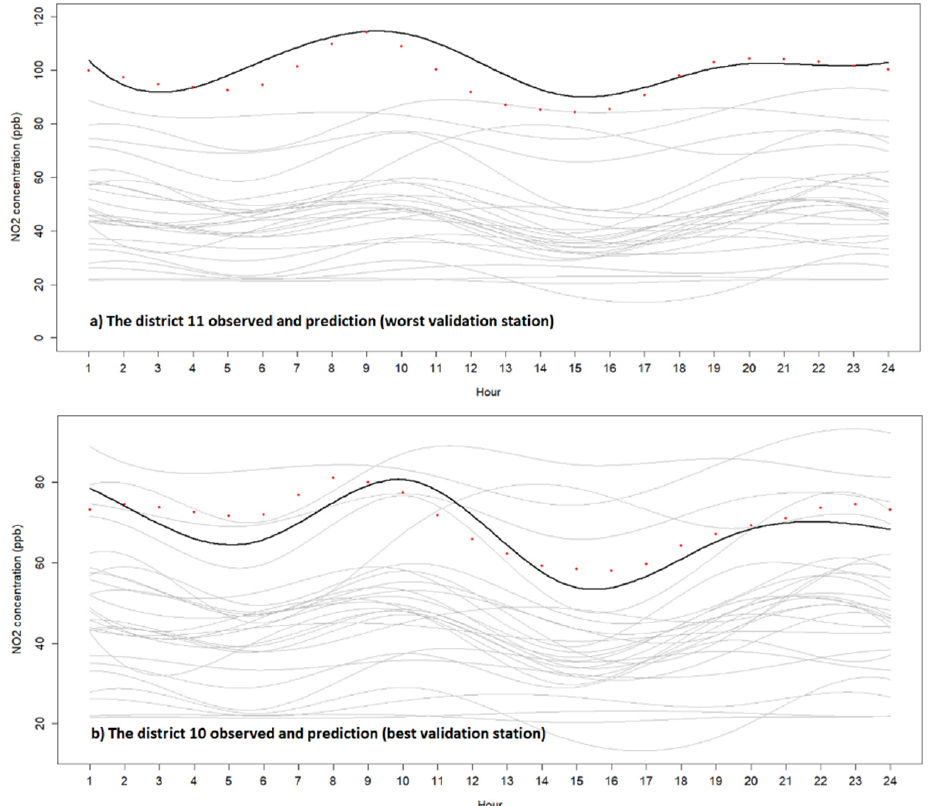
with respect to the Tehran averages and had approximately the same value from 9 a.m. to